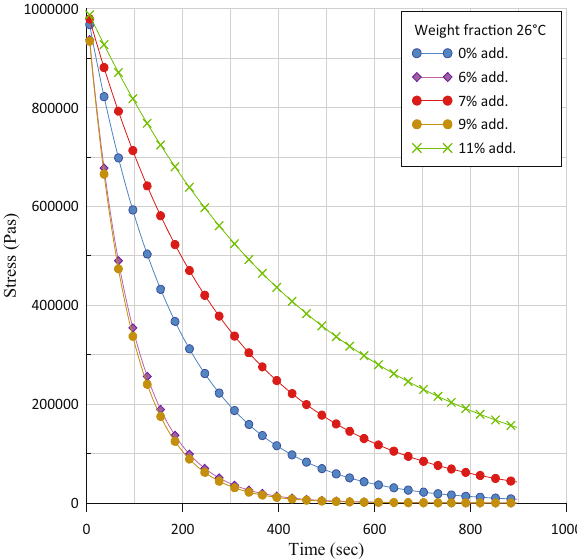
Figure 11: Stress versus time for UP/PS reinforced with fi sh with di ff erent weight fractions at 26°C.